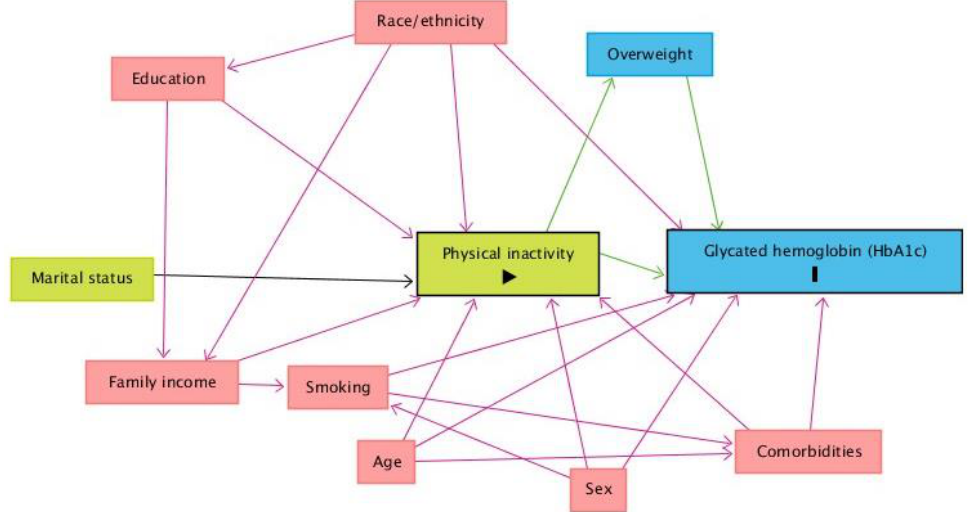
Figure 1. Directed acyclic graph (DAG) on glycated hemoglobin (HbA1c, outcome variable) and physical inactivity (exposure variable). Legend: The variable in green and with the symbol “>” inside the rectangle is the exposure variable. The variable in blue and with the letter “I” inside the rectangle is the outcome variable; Key: The variable with symbol “>” inside the rectangle is the exposure variable. In blue and with the letter I is the outcome variable; variables in blue are the antecedents of the outcome variable, and those in red are the antecedents of the outcome and exposure variables. Black arrows are non-causal and unbiased paths; green arrows are causal paths between the explanatory variable and outcome variable or antecedents; red arrows are biased